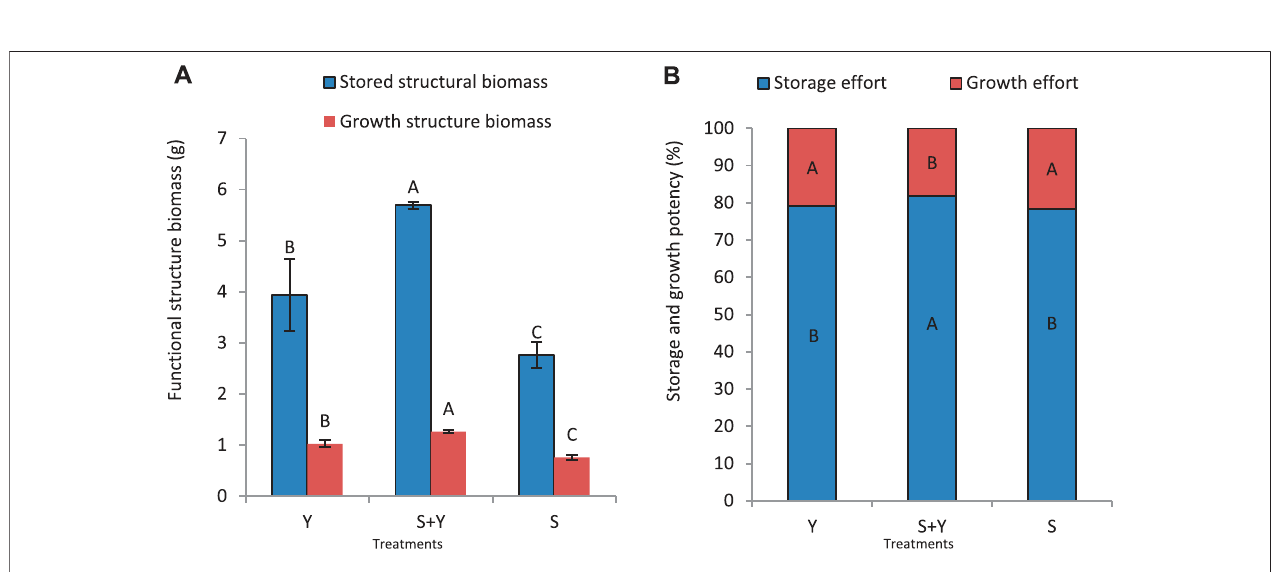
FIGURE 9 | Trade-off between grazing methods on the storage and growth of K. humilis in terms of (A) storage structure and growth structure biomass, and (B) storage structure and growth structure effectiveness. Capital letters indicate signi fi cant differences among grazing methods ( p < 0.05).